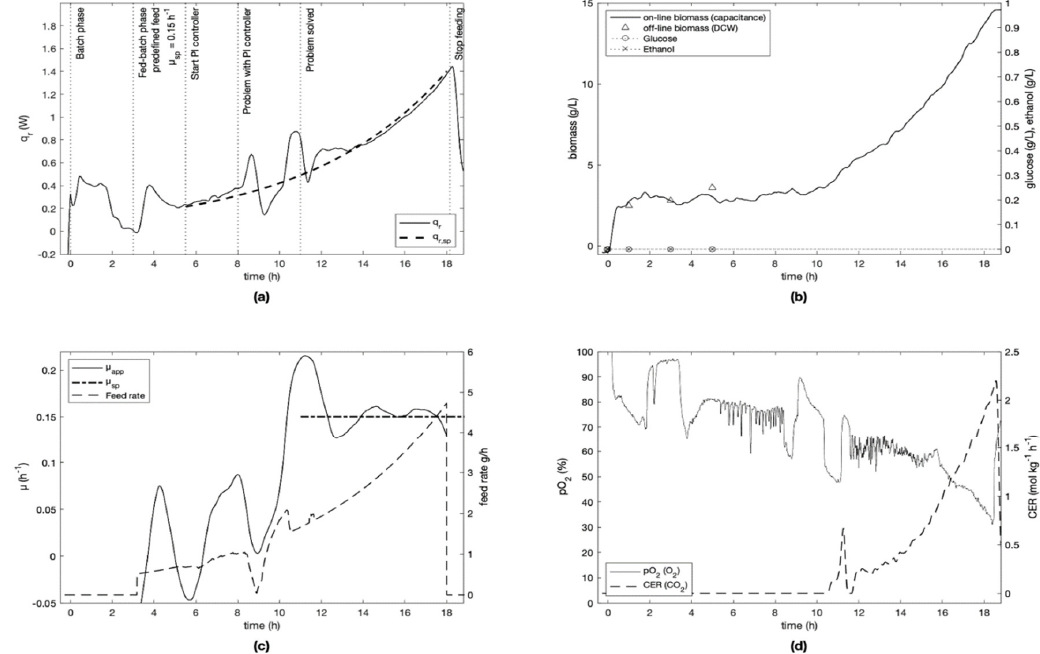
Figure 5. Fed-batch culture (E-3) of S. cerevisiae with µ sp of 0.15 h − 1 . ( a ) q r and q r,sp profiles. Events indicated by vertical lines. ( b ) Biomass profiles. Glucose and ethanol concentrations. ( c ) µ app from dielectric spectroscopy, µ sp and F feed . Controller MRE of 17% achieved. ( d ) pO 2 and CER. A problem occurred with data communication to the PI controller between 8 h and 11 h, hence the large variation on all metabolic signals.